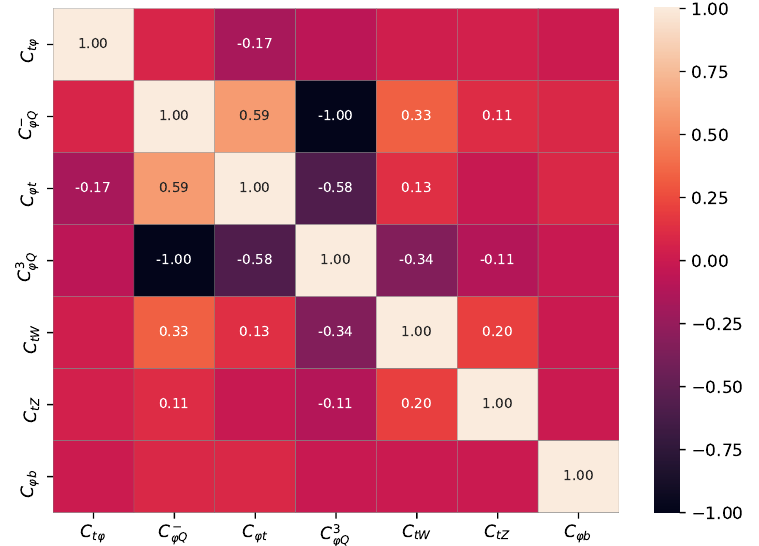
Figure 9 . Correlation matrix between the different EFT operators obtained in the linear (Λ − 2 ) “All correlations” robustness test fit described in section 8.3. Cells are filled if the correlation is higher than 10% in absolute value. The operator O ϕb , that modifies only the bottom quark electro-weak couplings, is taken into account in the fit but limits on its coefficients are not reported since the obtained values are not competitive using only the observables considered in our fit.